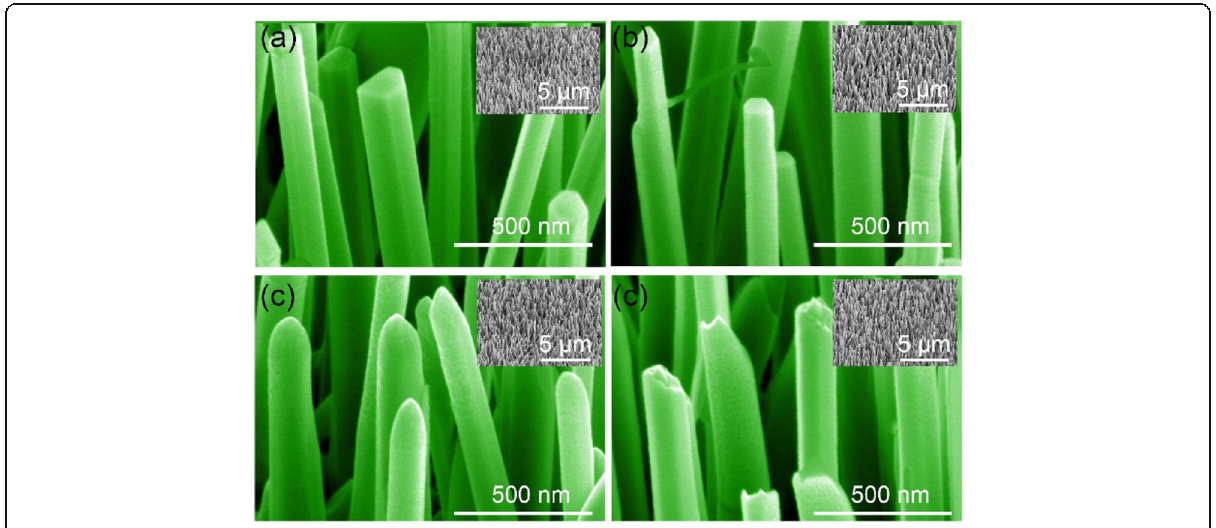
Fig. 1 SEM image of the ZnO NWs irradiated by Ar plasma with different energies. a As-grown. b 0 W. c 200 W. d 400